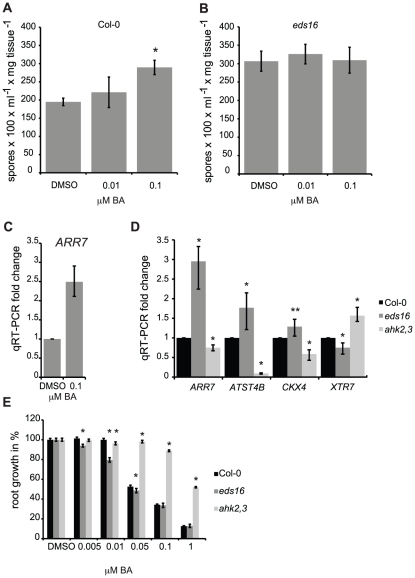
SA negatively regulates cytokinin signaling.Susceptibility of cytokinin-treated wild-type (A) and eds16 (B) plants to Hpa Noco2. Two-week-old plants were sprayed with the indicated concentrations of BA or DMSO control 48 hours prior to inoculation with Hpa Noco2. Spore production was measured as described in Methods. Error bars represent SE (n≥4). Asterisks indicate statistically significant differences from wild-type plants (p-value<0.05, two-tailed student's t-test). The experiment was conducted in parallel for all genotypes above and repeated at least three times independently. Data from one representative experiment are shown. (C) ARR7 expression in response to cytokinin treatment. RNA was extracted from two-week-old wild-type plants from (A) that had been sprayed with the indicated concentration of BA or DMSO control, 48 hours after treatment. Levels of ARR7 were determined by qRT-PCR relative to DMSO samples. Error bars represent SE from three technical replicates and correspond to upper and lower limits of 95% confidence intervals. At least three independent biological replicates of the experiment were conducted with similar results. Data from one representative independent biological replicate are shown. (D) Basal expression of cytokinin-regulated genes in wild-type, eds16 and ahk2,3 plants. RNA was extracted from tissue harvested from untreated two-week-old seedlings. Levels of transcripts were determined by qRT-PCR relative to wild-type samples. Error bars represent SE from three technical replicates and correspond to upper and lower limits of 95% confidence intervals. At least three independent biological replicates of the experiment were conducted with similar results. Data from one representative independent biological replicate are shown. Statistically significant differences from wild-type plants (one-tailed student's t-test) are represented by asterisks (* = p-value<0.05, ** = p-value<0.075). (E) Primary root elongation assay for cytokinin sensitivity. Wild-type, eds16 or ahk2,3 seedlings were grown vertically on plates supplemented with the specified concentrations of BA or DMSO control under constant light conditions at 23°C. Primary root elongation between days 4 and 9 was measured as described in Methods. Results shown were pooled from an experimental set of three independent samples of 10 to 15 individual seedlings each. Asterisks indicate statistically significant differences from the wild type at the given concentrations of BA (two-tailed student's t-test, P<0.05). Error bars represent SE (n≥22). This experiment was repeated twice with consistent results.